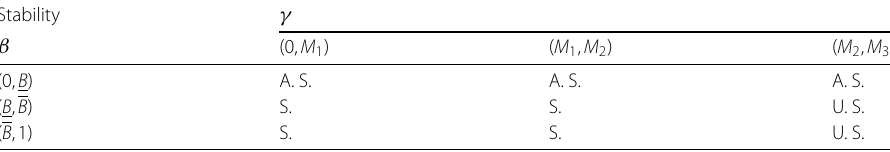
Table 2 The stability properties of the disease-free equilibrium point when E < e < E Stability